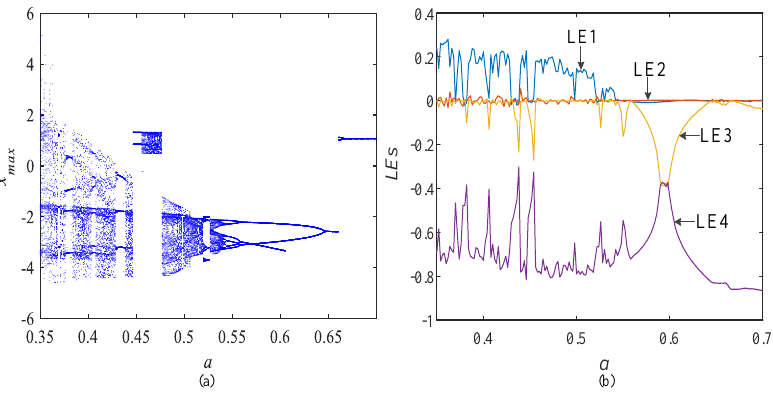
Figure 4. Dynamics with a change: ( a ) bifurcation diagram; ( b ) Lyapunov exponents.